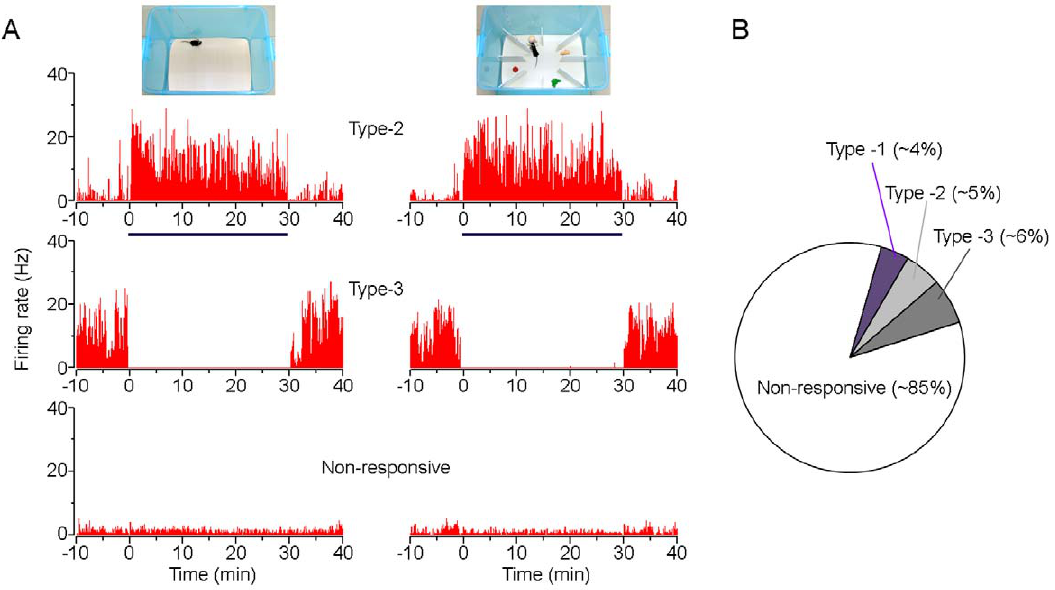
Figure 2. BLA neurons differentially respond to novel environmental exposure. (A) Rate histograms of three simultaneously recorded BLA neurons (type-2, top panels; type-3, middle panels; and a non-responsive neuron, bottom panels) during the open field (left) and enriched box (right) exposure. (B) Percentages of the each type of BLA neurons.